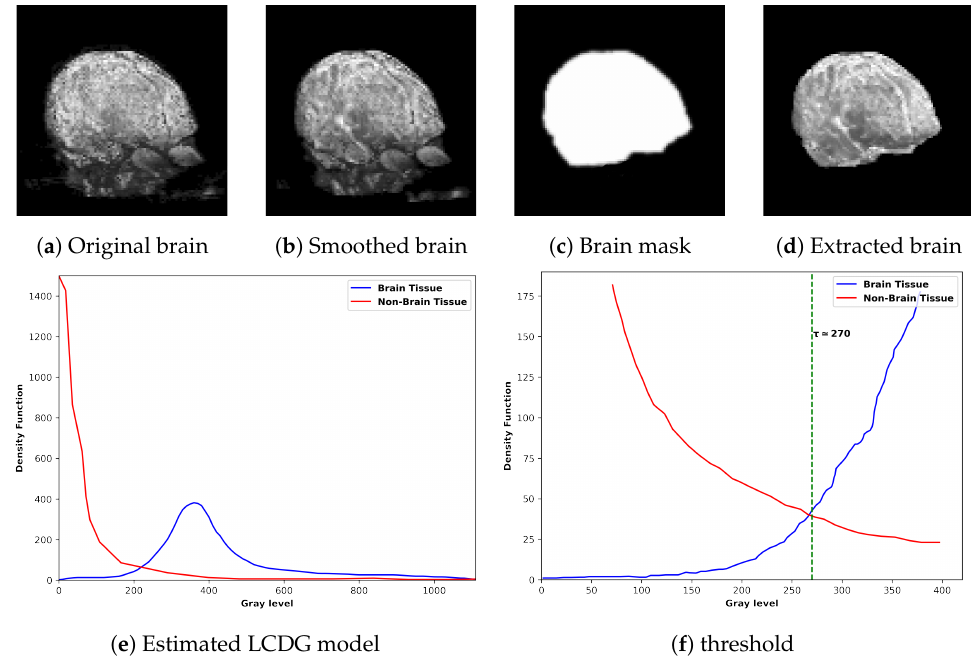
Figure 2. ( a – d ) Procedure of extracting the brain starting from original volume, ( e ) the final estimated LCDG density for each of the two classes: brain vs. non-brain, ( f ) the discriminant threshold τ calculation